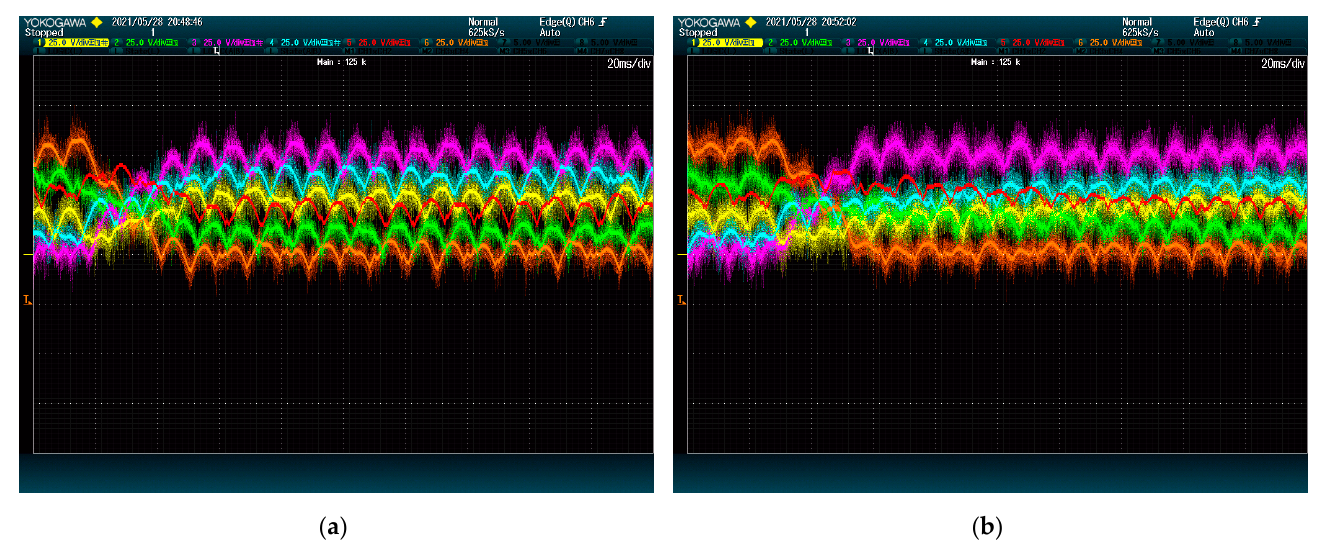
Figure 8. DC-Link voltage dynamics upon set point swap at 9 kVAr: ( a ) proposed method; ( b ) state-of-the-art alternative. The plots show voltage (25 V/div) vs. time (20 ms/div).